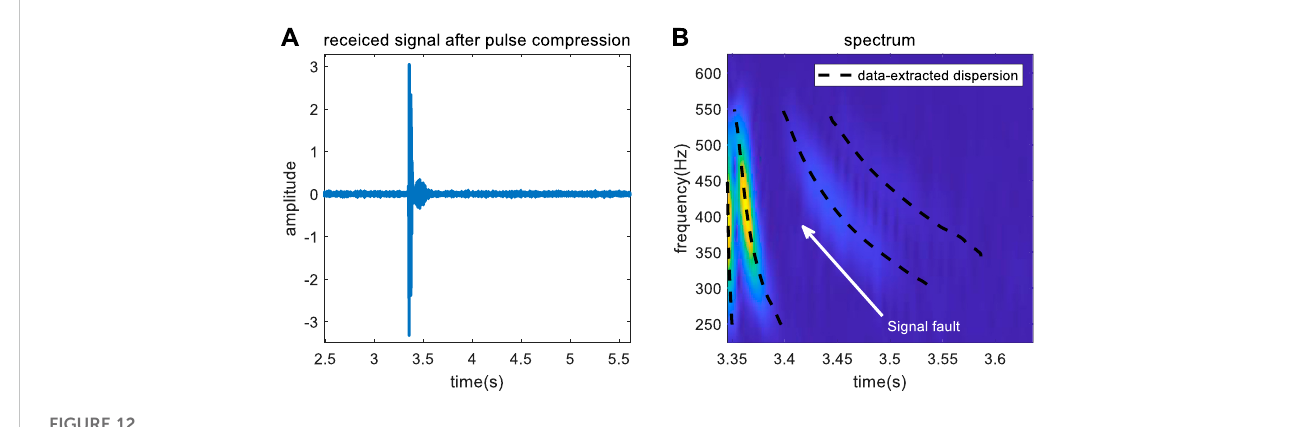
FIGURE 12 (A) Received data; (B) TFA of the warped signal.